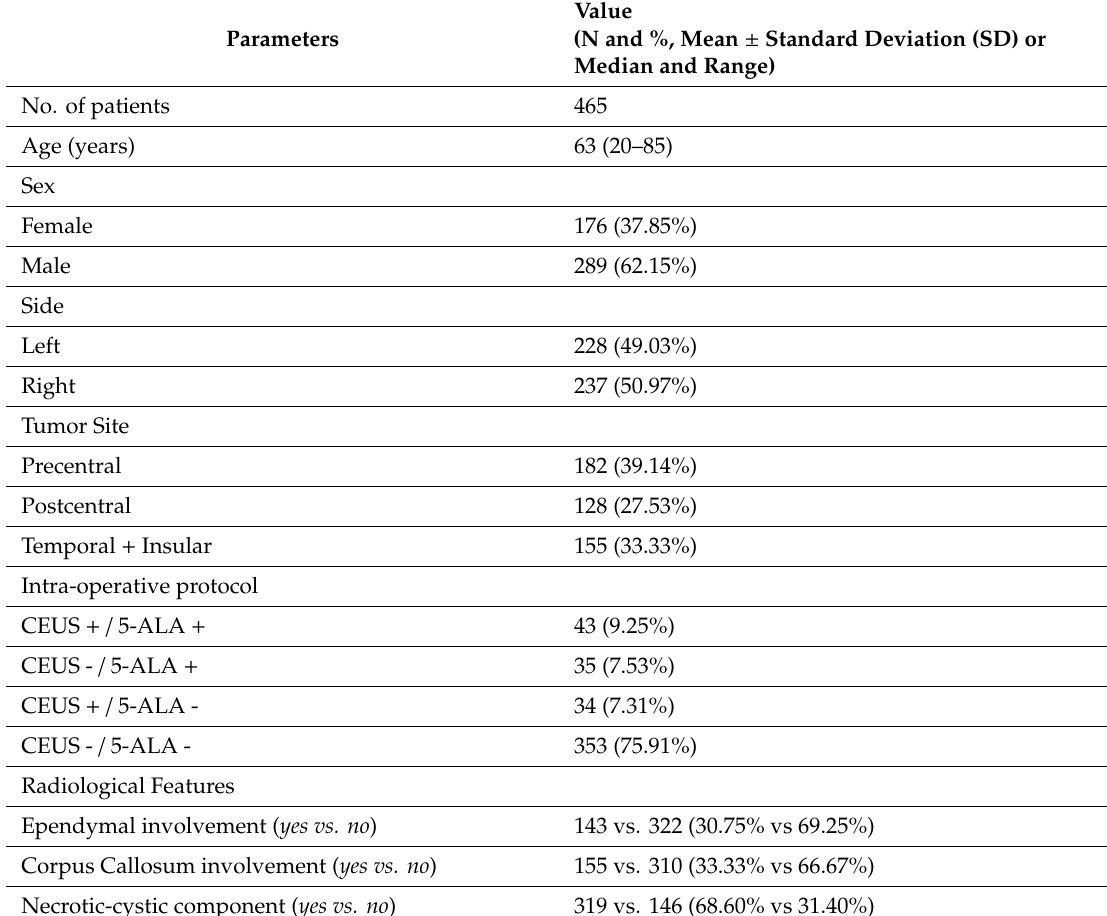
Table A1. Baseline characteristics of the study